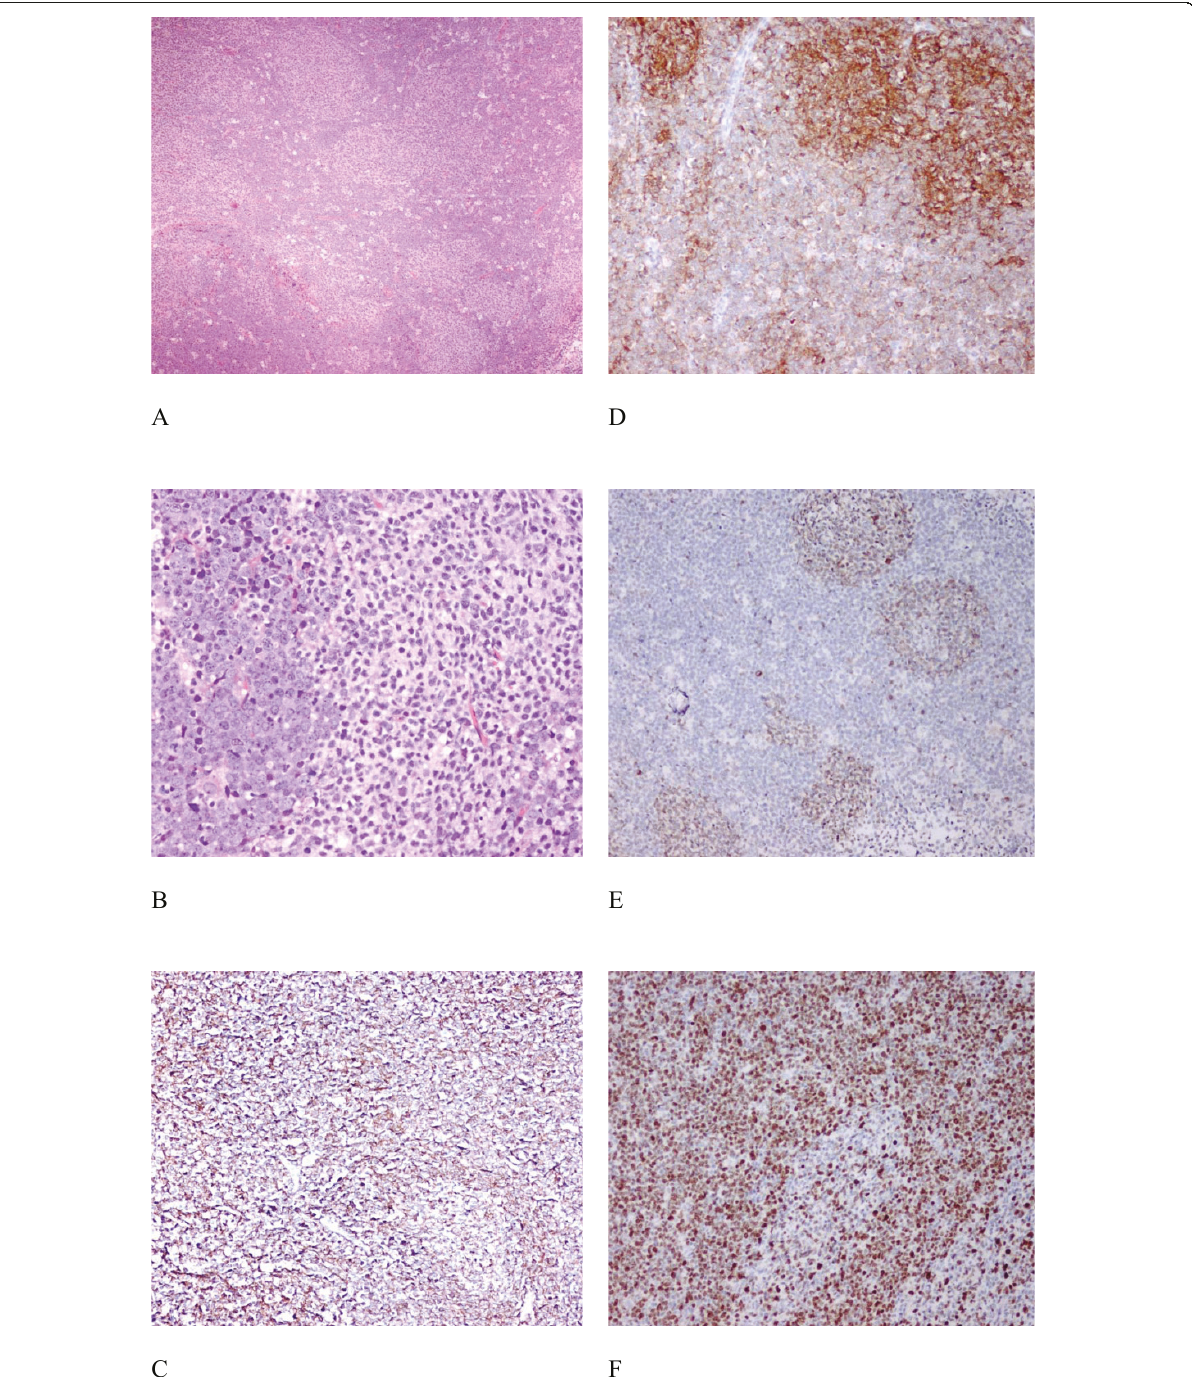
Figure 2 Histological features of the submandibular lymph node . The histology showed neoplastic follicles and a high grade interfollicular lymphomatous infiltrate featuring starry sky pattern (Figure 2A, × 40 H&E; Figure 2B, × 200 H&E) with frequent mitotic and apoptotic bodies. Immunohistochemical study showed that CD20 is strongly expressed in both the follicular and diffuse components (Figure 2C, H&E × 100), and CD10 is strongly expressed in the follicular component while it is only weakly positive in the interfollicular high grade component (Figure 2D, ×100). The neoplastic follicles are positive for BCL2 (Figure 2E, × 100) and around 95% MIB1 immuno-reactivity is noted in the interfollicular high grade lymphoma infiltrate (Figure 2F, ×